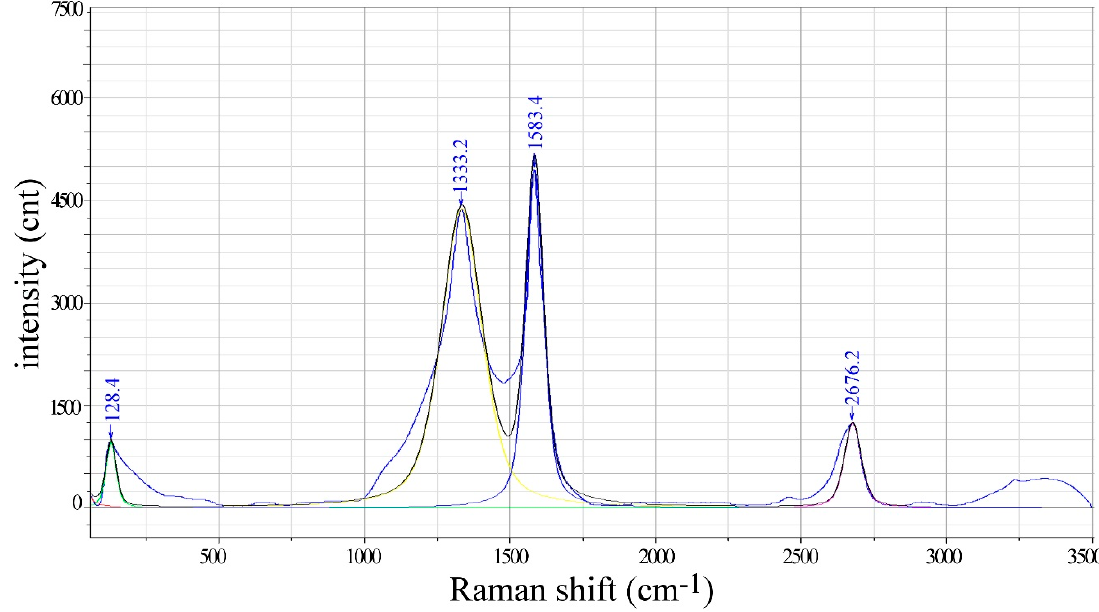
Figure 3. Raman spectrum for 40% w / w CNT in TPU composite fiber.